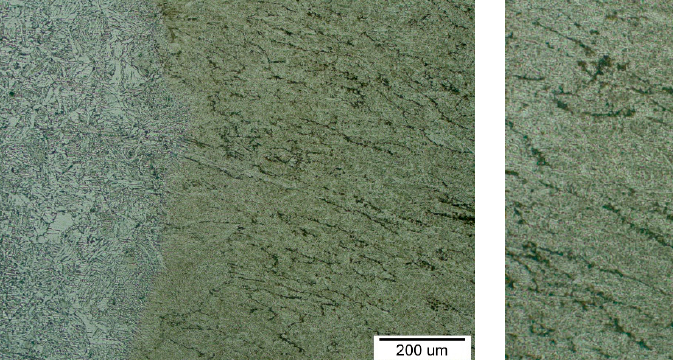
layer. ( b ) Microstructure in the middle of the first surfacing layer. Figure 5.